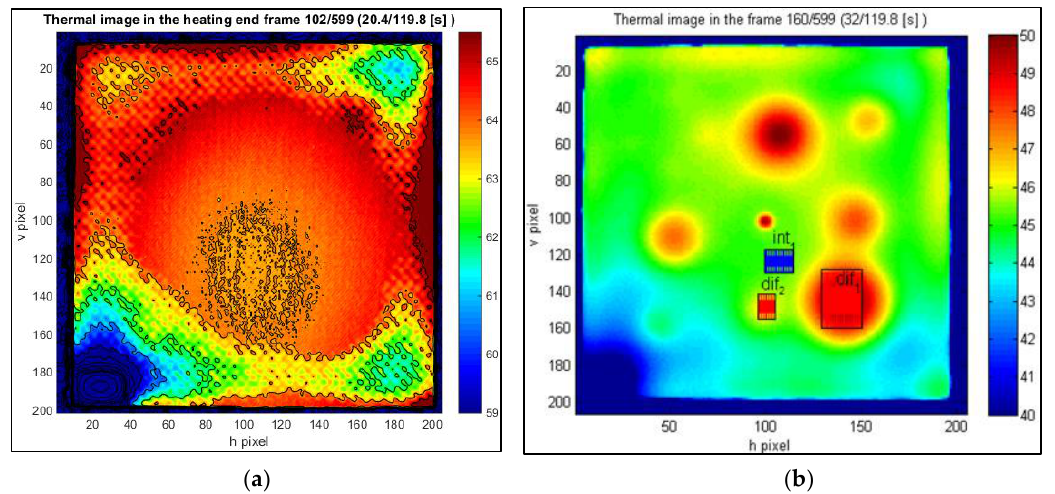
Figure 7. ( a ) Map of isotherms at the beginning of the cooling phase for artificial Plate I and ( b ) defect presence example on raw thermal image, using heating time of 20 s.